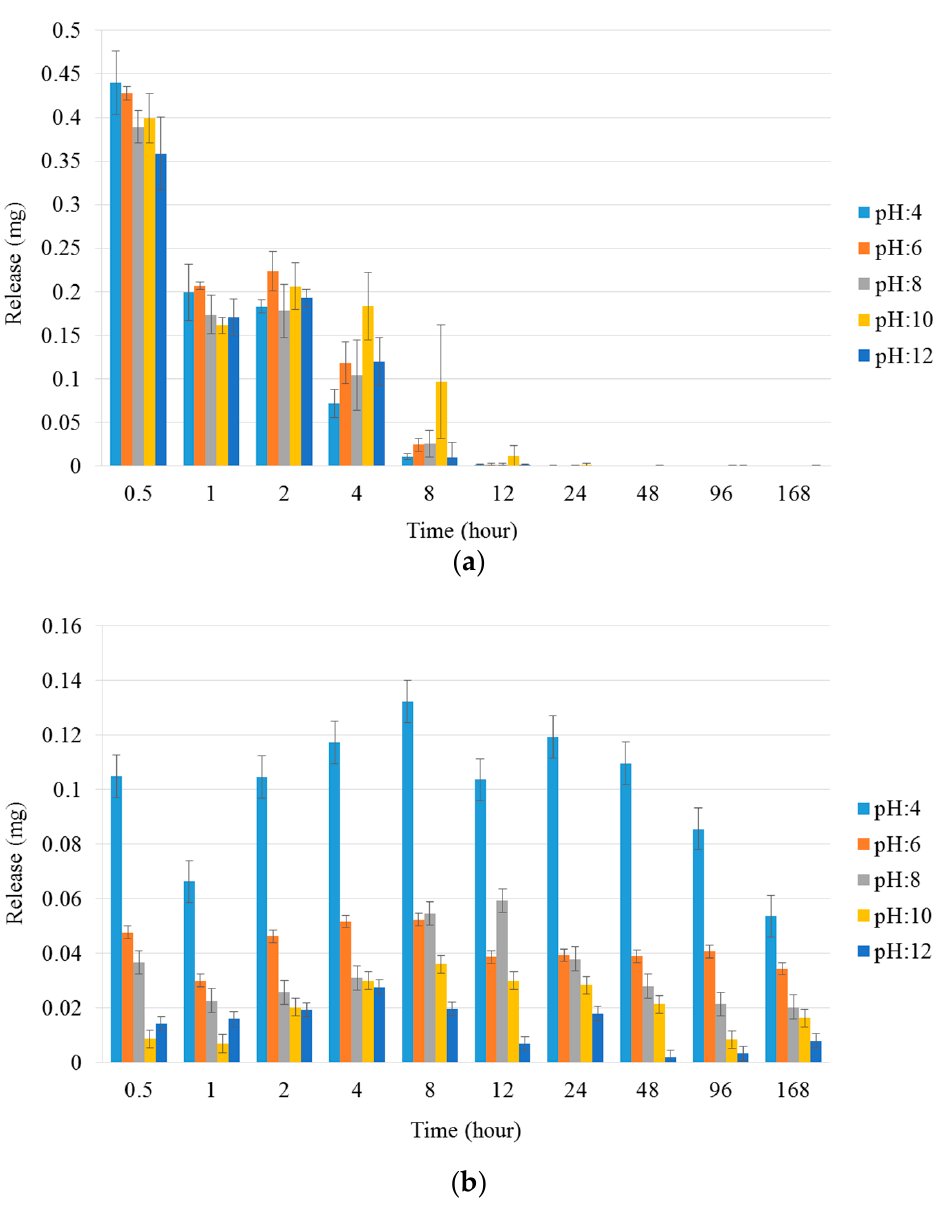
Figure 7. ( a ) Metr and ( b ) CHX release properties of NCHGs in different pH Britton–Robinson buffer solutions over a one week period. Values are expressed as sample means, error bars represent the standard deviation (SD) of three parallel measurements.